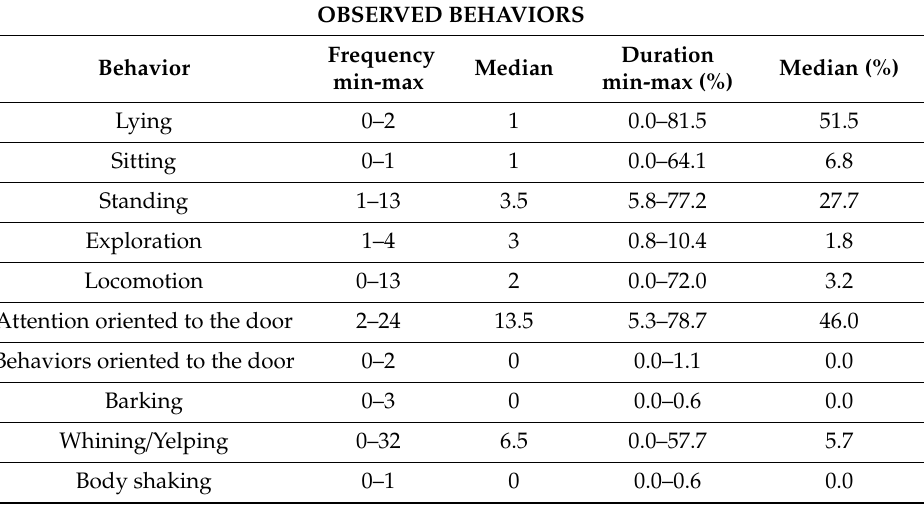
Table 3. Salivary ∆ OXT (oxytocin (T1)–(T0)) and cortisol concentration during NC (negative condition, consisting of 5 min of